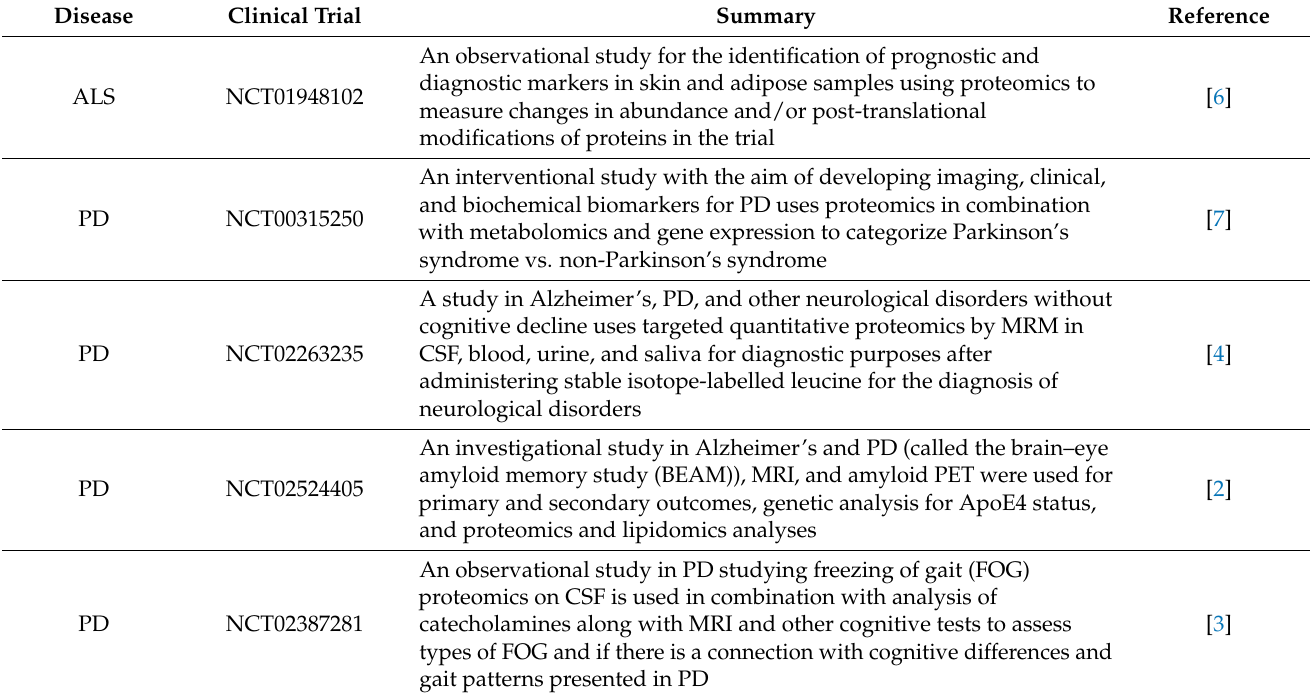
Table 4. Examples of clinical trials using proteomics in ALS and PD. Disease Clinical Trial